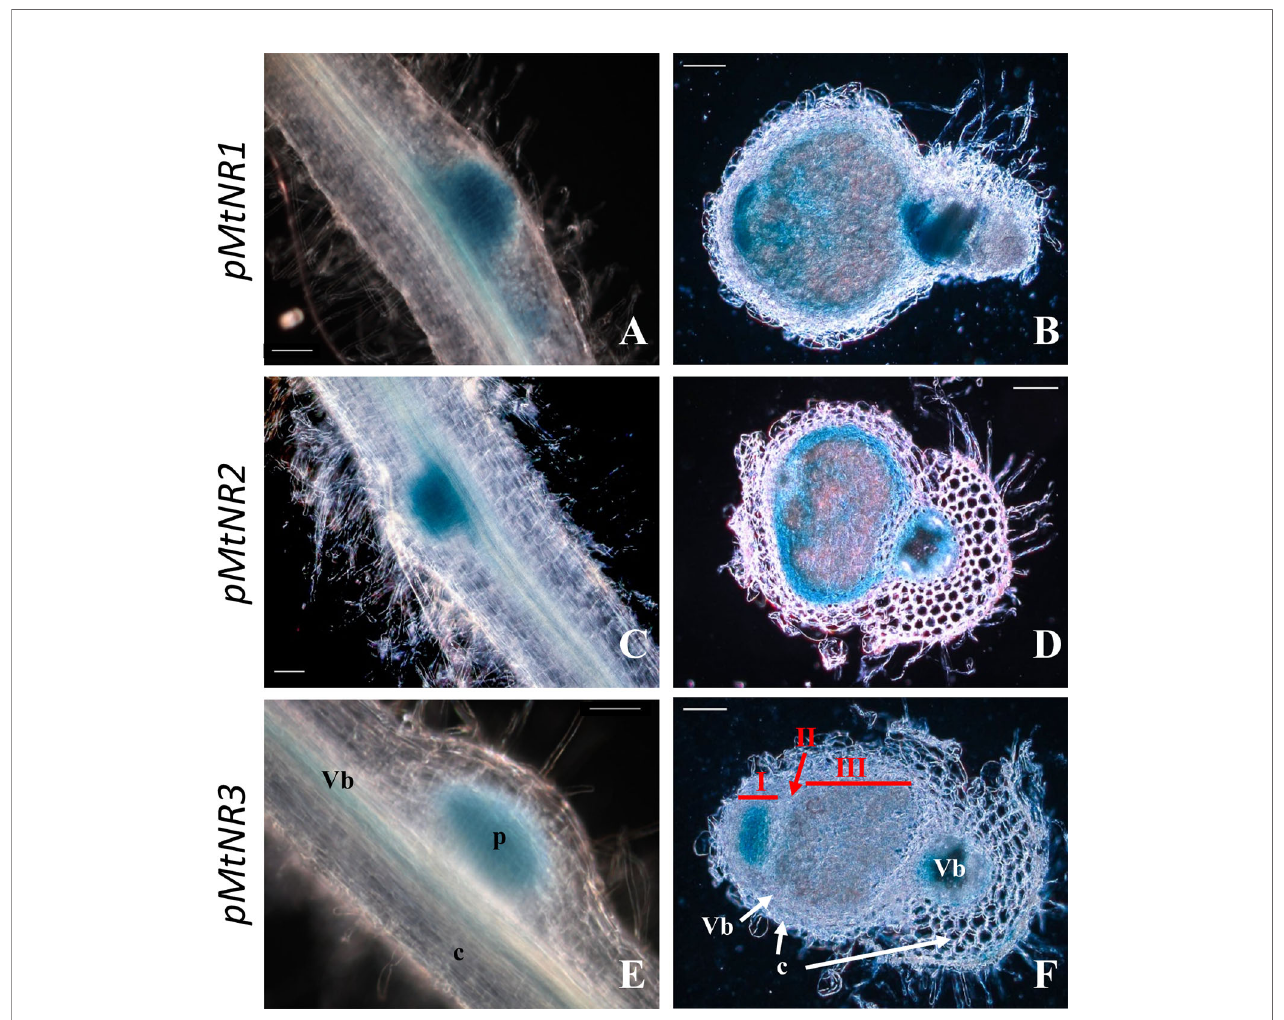
FIGURE 2 | Histochemical localization of MtNRs expression in Medicago truncatula roots. Localization of GUS activity in transgenic M. truncatula roots expressing the gusA reporter gene under the control of a 1.65 Kb MtNR1 promoter fragment (A, B) , of a 1.7 kb MtNR2 promoter (C, D) and of a 1.55 kb pMtNR3 promoter (E, F) . Whole root segment 4 dpi with S. meliloti (A, C, E) and longitudinal section of a 2 wpi old nodules (B, D, F) were stained for 3, 5, or 16 h with X-gluc for the GUS activity for pMtNR2, pMtNR1 , or pMtNR3 respectively. Zones I, II, and III of the nodule are represented in red in picture F. p, nodule primordium; Vb, vascular bundles; c, cortex. Scale bars, 50 µm for (A, C, E) ; 100 µm for (B, D, F)